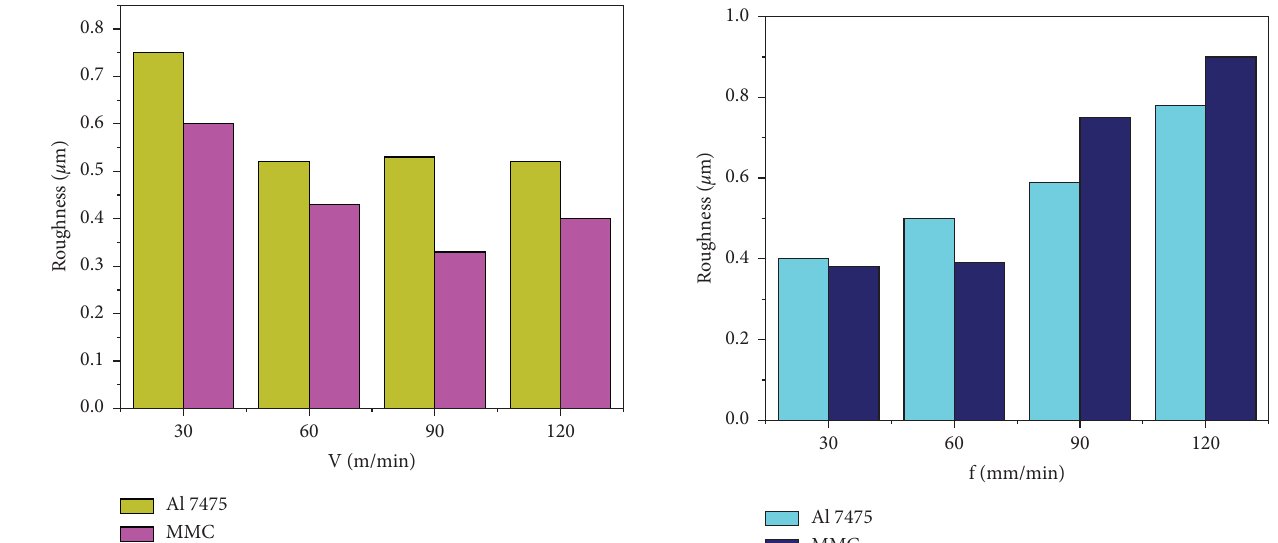
Figure 5: Comparison of V on R